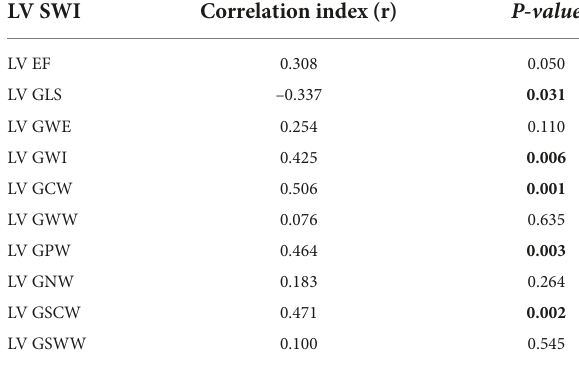
TABLE 4 Correlation analysis results between some echocardiographic indices and left ventricular stroke work